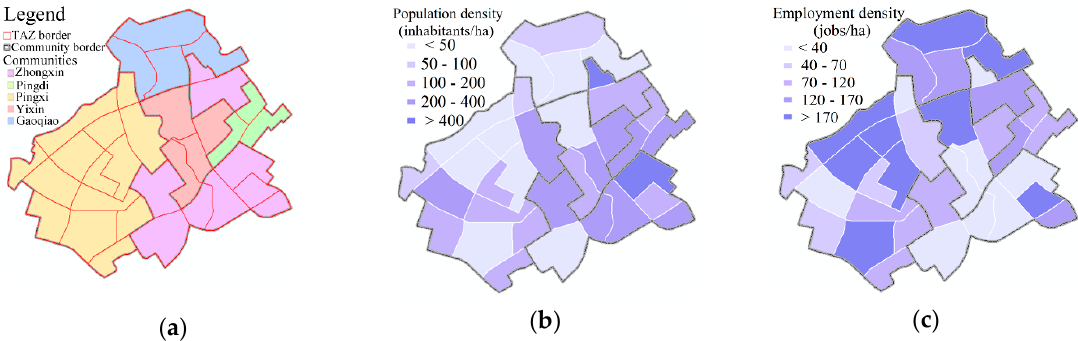
Figure 5. Division of TAZs ( a ), population density ( b ), and employment density ( c ) in the study area.